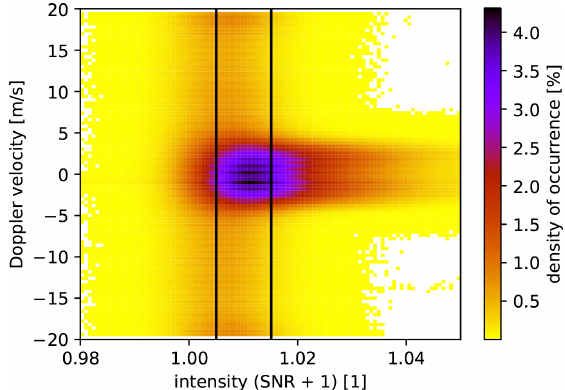
Figure 4. Intensities (SNR + 1) vs. Doppler velocities on 2 Septem- ber 2019 for all center-of-range gates during a 24h observation pe- riod. The DWL is operated in CSM2 with a 62 ◦ elevation angle, and it produced 25million measurements on that day. The area is divided into 100 × 100 bins, and the colors indicate the density of occurrence. The left vertical line corresponds to an SNR value of − 23dB and the right to − 18 .